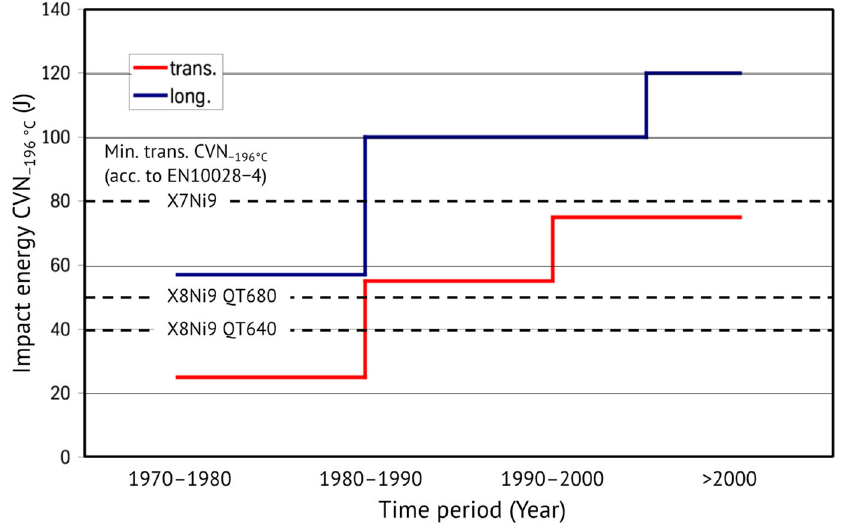
Figure 16. Evolution of market-driven toughness requirements for 9%Ni steel at − 196 ◦ C in rolling and transverse direction (specified minimum toughness at − 196 ◦ C acc. to EN10028-4 is represented by dashed lines).